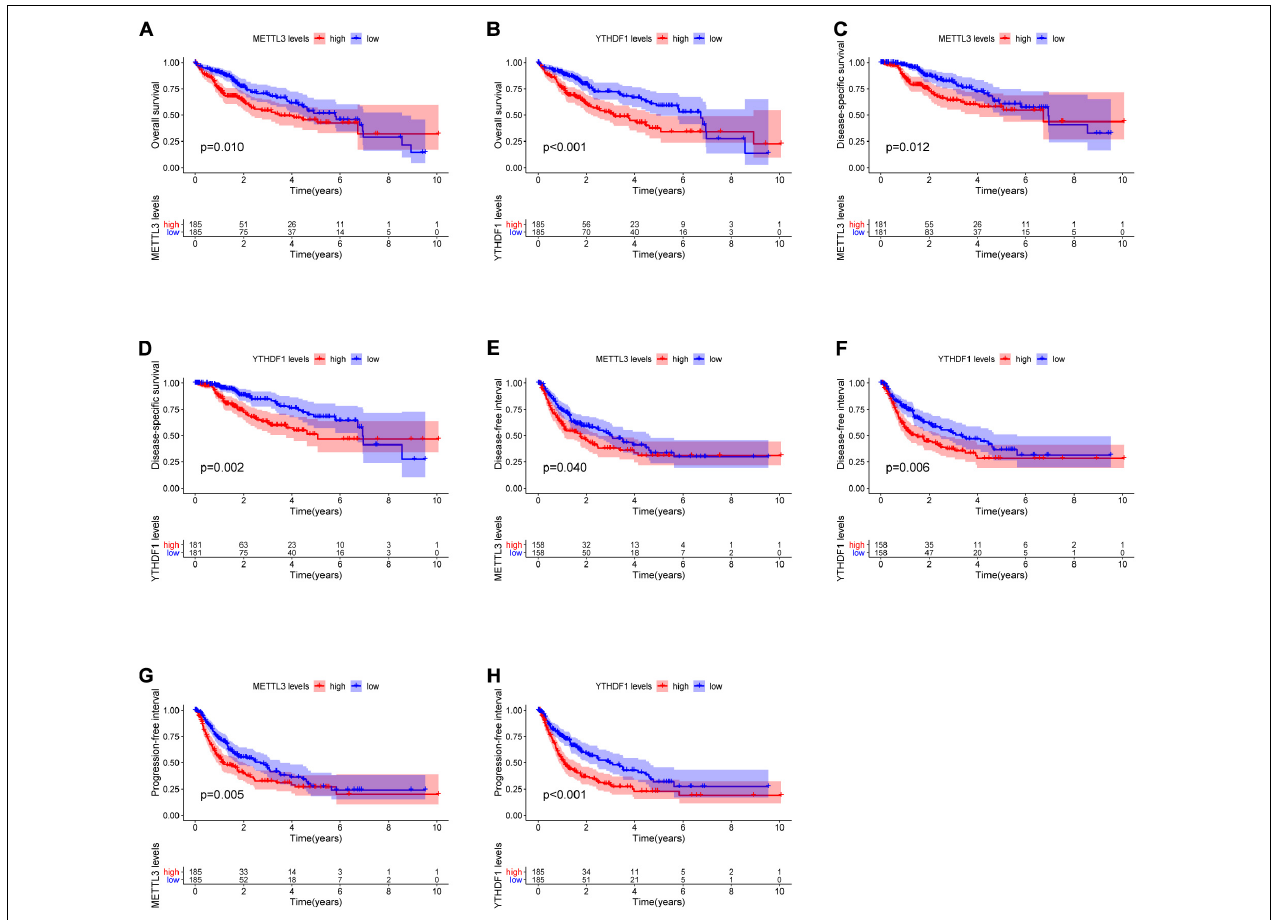
FIGURE 2 | The Kaplan–Meier curves for OS, DSS, DFI, and PFI in LIHC. Kaplan–Meier survival curves showing differences in OS (A,B) and DSS (C,D) stratified according to METTL3 and YTHDF1 expression. Kaplan–Meier survival curves showing difference in DFI (E,F) and PFI (G,H) stratified according to METTL3 and YTHDF1 expression. LIHC, liver hepatocellular carcinoma; OS, overall survival; DSS, disease-associated survival; DFI, disease-free interval; PFI, progression-free